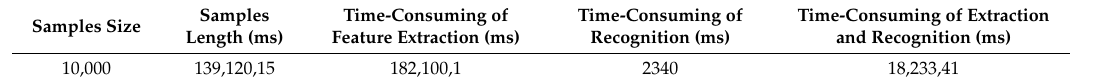
Table 5. Time-consuming of feature extraction and recognition.